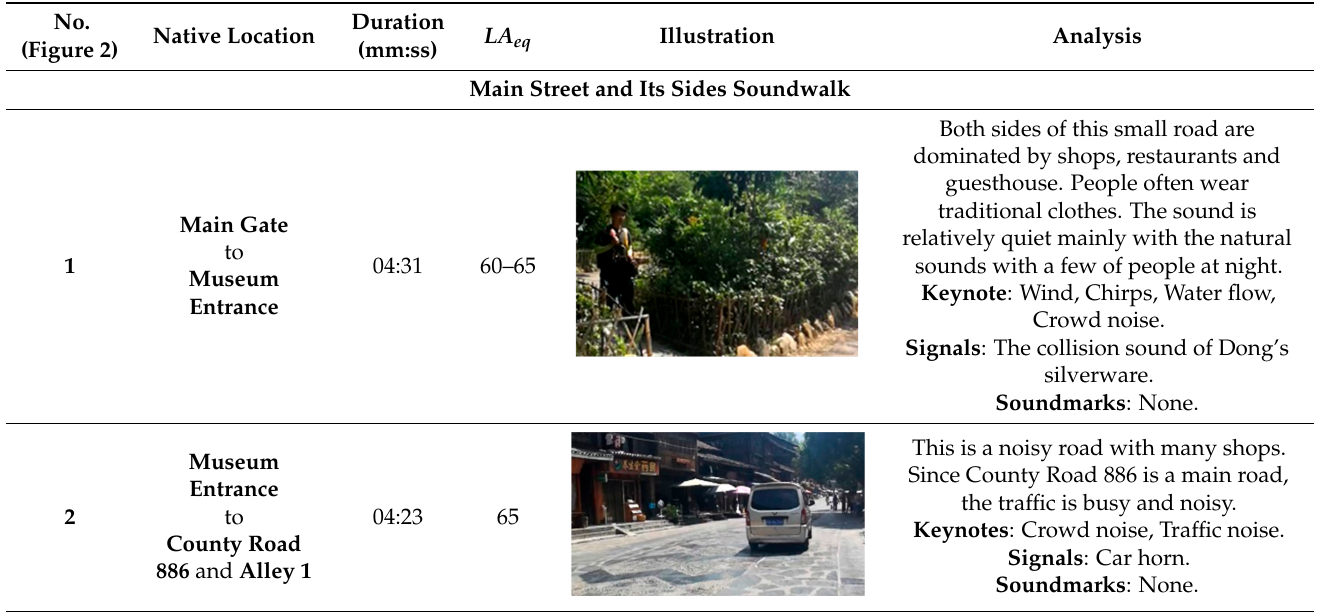
Table 2. Soundscape features